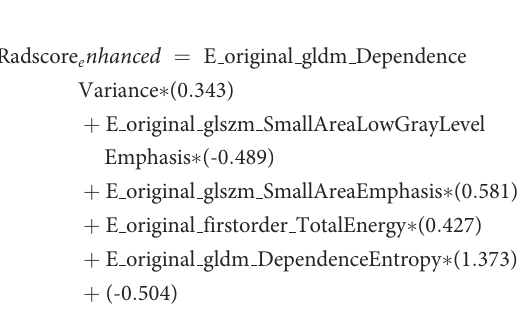
TABLE 1 Detailed clinical information, CT manifestations and pathological types.